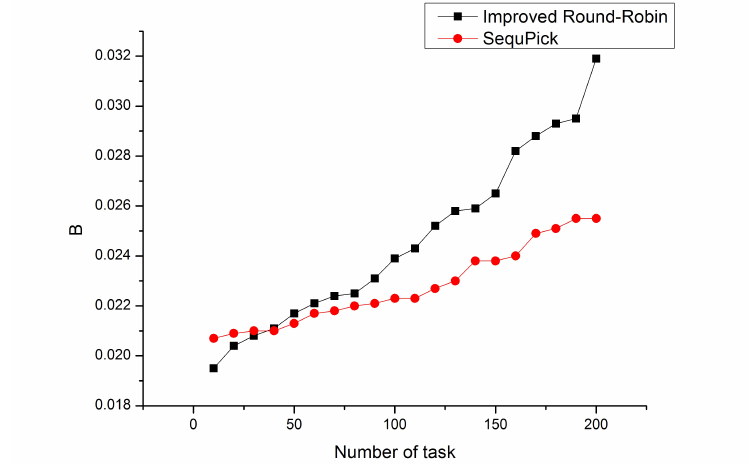
Figure 6. Improved Round-Robin vs.